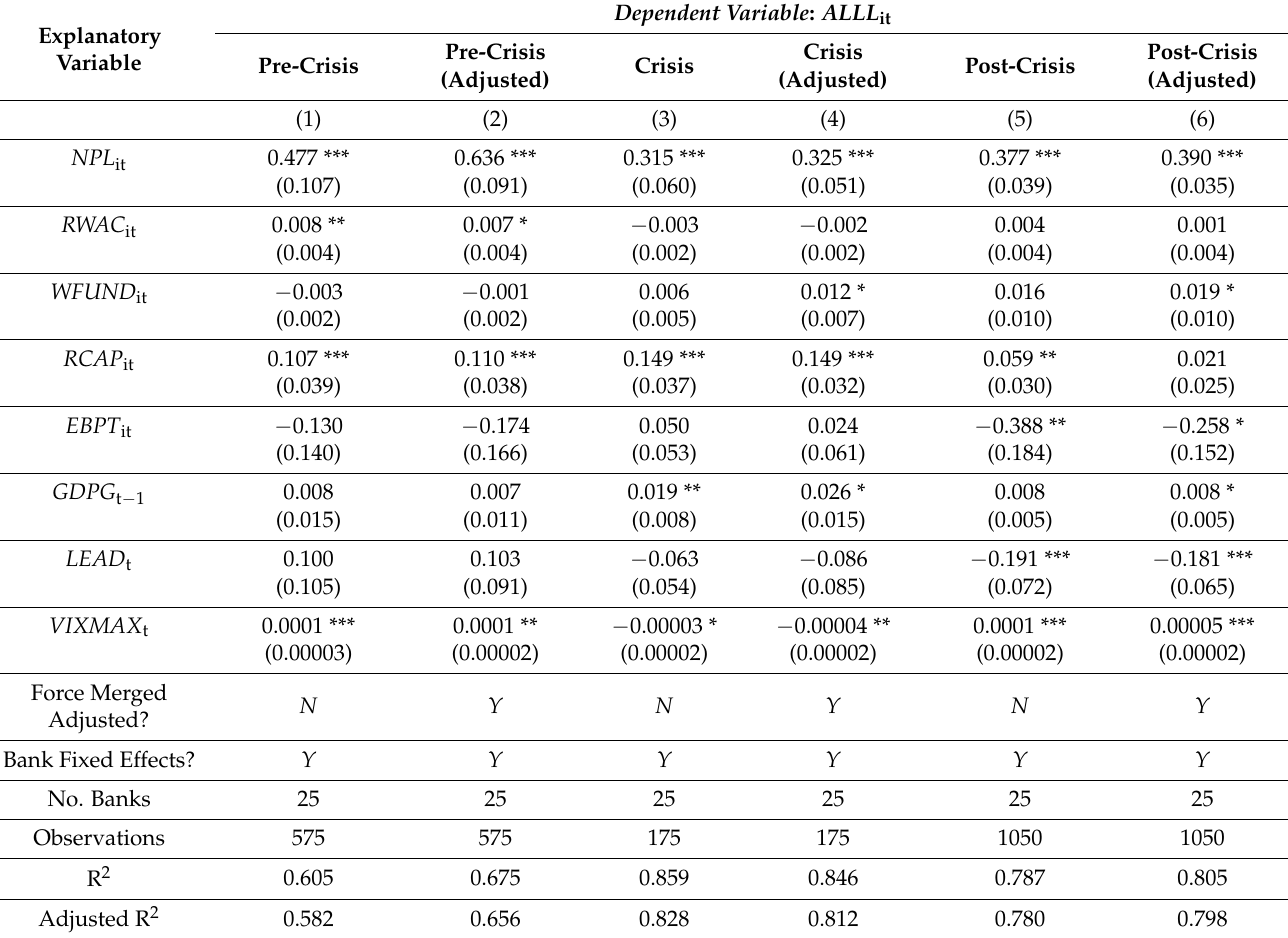
Table 6. How do U.S. bank holding company loan loss allowances vary over the business